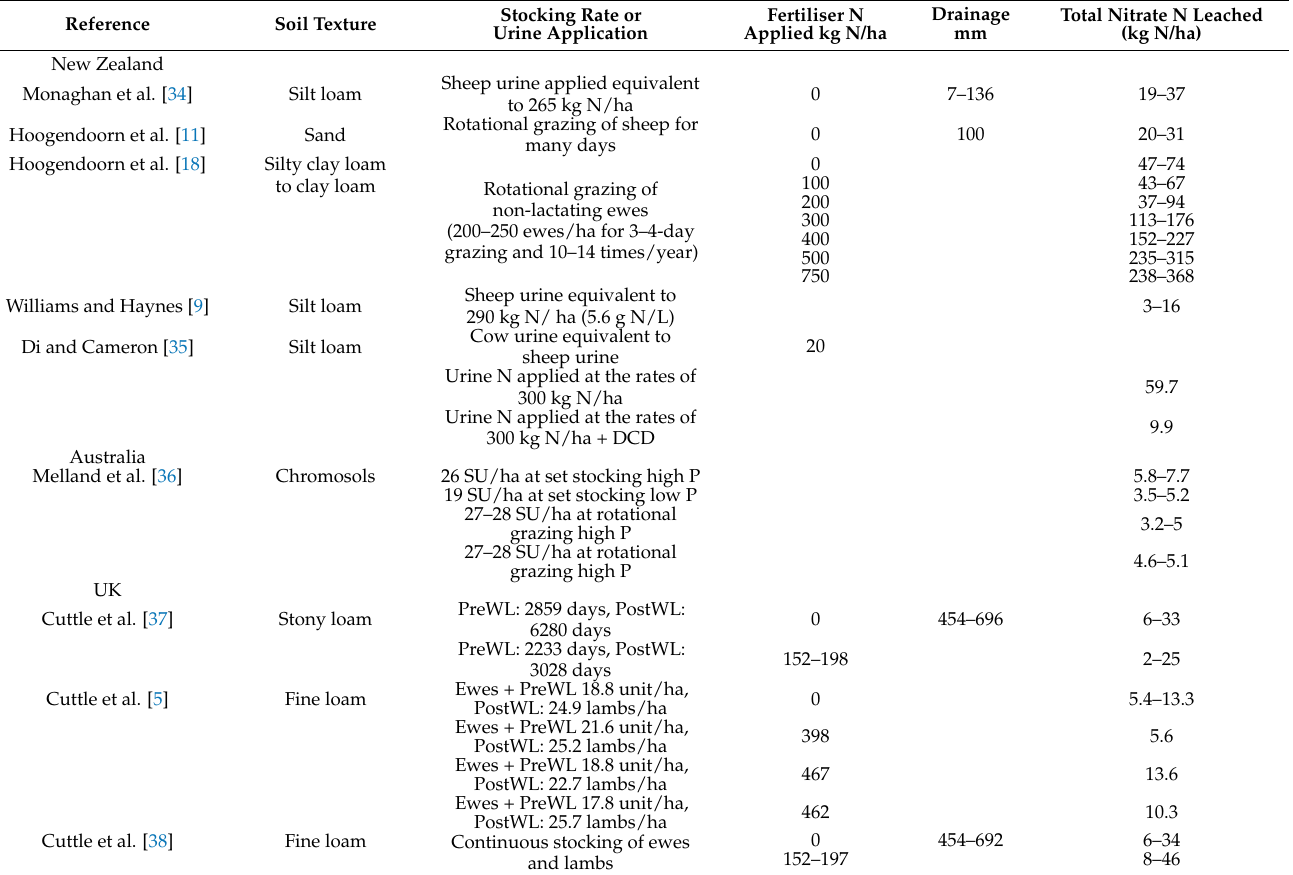
Table 1. Summary of nitrate nitrogen (N) leaching in sheep grazing pasture systems measured using lysimeter or ceramic cups at different